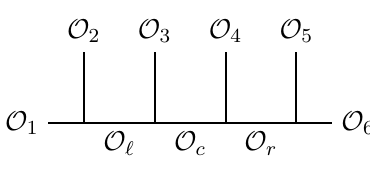
( x i ), in the comb channel. We will not (cid:1) ‘ ;(cid:1) c ;(cid:1) r